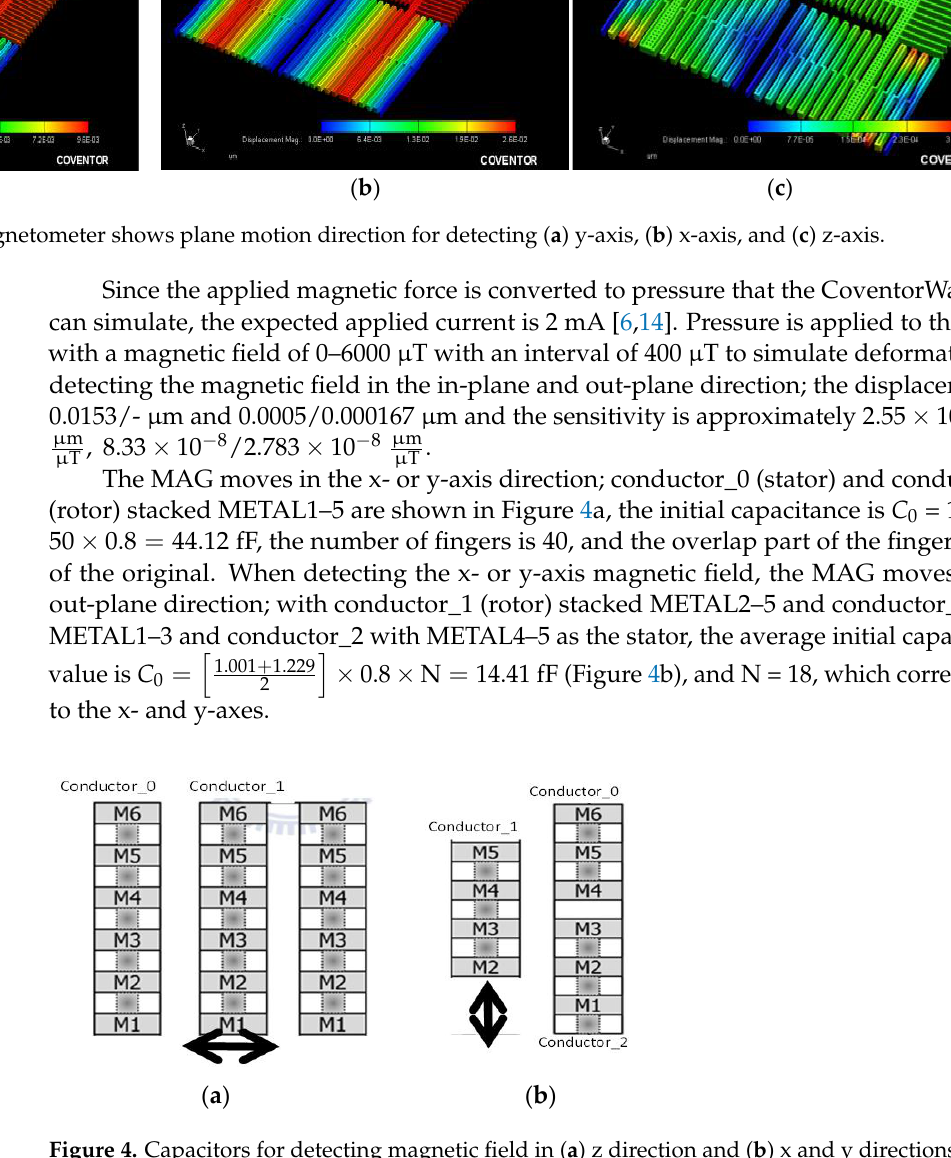
Figure 4. Capacitors for detecting magnetic field in ( a ) z direction and ( b ) x and y directions. Displacement ( 𝑑 ) and capacitance variance ( ∆C) are equal to 𝐶 × ∆𝑑 . When detect- 0 𝑑 ing a z-axis magnetic field of 6000 μT, the displacement and capacitance variance of the MAG along the x-axis at the frequency 𝑓 𝑂 are 256 nm and 1.815 fF, and in the y-axis di- rection are 53.6 nm and 0.624 fF. When detecting an x-axis magnetic field of 6000 μT, the displacement and capacitance variance of the MAG along the z-axis at resonance are 30.8 nm and 0.058 fF. Then, we calculate the three-axis capacitance change values for 16 g acceleration and at resonance frequency: ∆𝐶 𝑥 = 0.0205 fF, ∆𝐶 𝑦 = 0.0205 fF, and ∆𝐶 z = 0.296 fF . Because the Q value has an important influence on the structure, the general damping constant is divided into squeeze and slide [11]. The viscosity of air at 760 torr and 300 K is 1.86 × 10 −5 kg/ms and is set as the default value in the simulator, according to [15,16]. Then, finite element method (FEM) simulation software can be used to simulate the damping coefficient of the structure’s out-plane motion; the slide damping coefficient under an out-plane motion for ambient pressure of 760 torr is dominantly affected, and is about 6.874 × 10 −7 ( N m s ) at the resonance frequency. The Q value can be estimated as follows: Q = 2𝜋𝑓 0 𝑀 𝑏 , where 𝑓 0 is the resonance frequency, M is the mass, and 𝑘 = 𝐹 𝑥 = 0.0024335(μN) 0.00016742(μm) ~14.535 , Q 𝑜𝑢𝑡−𝑝𝑙𝑎𝑛𝑒 = √𝑚𝑘 b = 1.069×10 −4 6.874×10 −7 ~155.57 . When moving in the in-plane motion along the y-axis, the squeeze and slide coeffi- cients for the in-plane motion for ambient pressure of 760 torr are 𝑏 = 4.433052 × 10 −7 + 2.548642 × 10 −6 ~2.992 ∗ 10 −6 ( N m s ) , 𝑘 = 𝐹 𝑥 = 0.0024335(μN) 0.00016742(μm) ~14.535 ( N m ) , Q 𝑖𝑛−𝑝𝑙𝑎𝑛𝑒 = √𝑚𝑘 b ~25.3 . Finally, the equivalent Brownian noise for ACC is 1.44615 μg √Hz [17]. In addition, the CoventorWare tool is used to simulate the applied pressure and convert it into force (F) and displacement (x), and according to Hooke’s law F = kx, the x- and z-axis spring con- stants are calculated, shown by 𝑘 𝑥 = 0.857 N m , 𝑘 𝑧 = 4.0446 N m . The Brownian noise equivalent magnetic field (BNEM) for the x-, y-, and z-axes of the MAG for ambient pressure of 760 torr are shown by BNEM 𝑥 = 32.78 nT √Hz , BNEM 𝑦 = 99.93 nT √Hz , and BNEM 𝑧 = 257.53 nT √Hz [18]. 4. Simulation Results of Finite Element Method for MEMS Resonator 4.1. Operational Principle of MEMS Resonator Figure 5 shows a fully differential electrostatic MEMS transducer resonator com- posed of driving electrodes, movable elements, and sensing electrodes. Assuming that the area of cross-section A is the overlap between rotor and stator, gap d 0 is the spacing when the MEMS is in the neutral position and ε is the permittivity of the material. If there is a displacement x between stator and rotor, the capacitance is given by 𝐶 𝑑𝑟𝑖𝑣𝑒 =